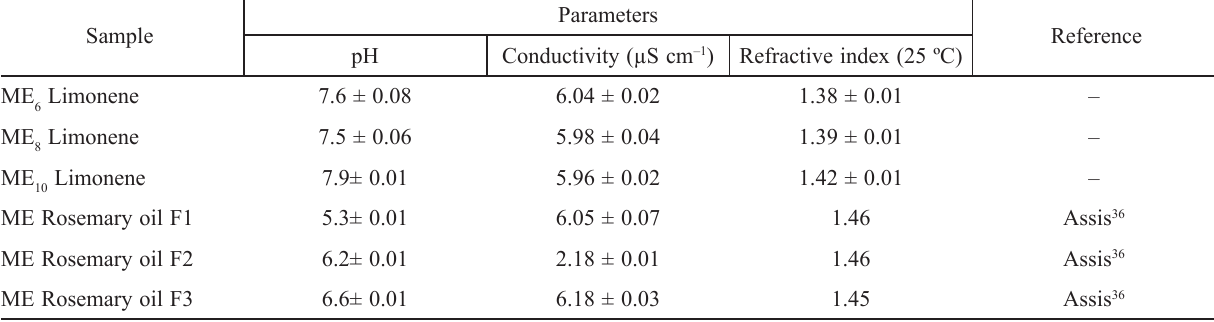
Table 5 – Parameters of pH, electrical conductivity, temperature, and refractive index, and their comparison with the literature